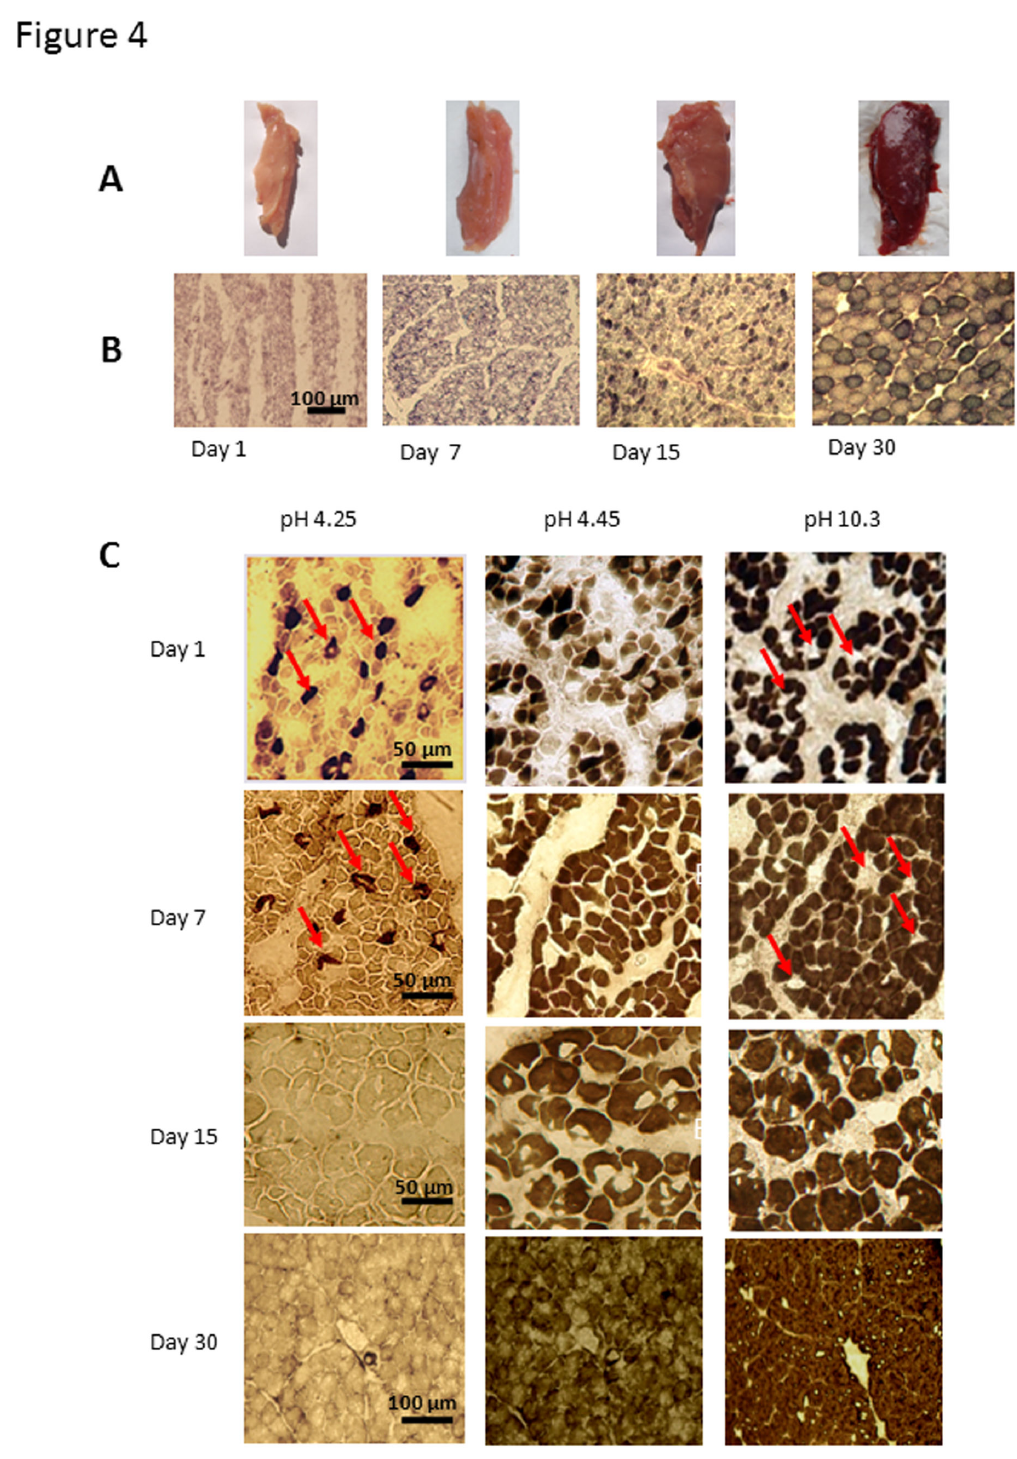
Figure 4. Morphological and histochemical properties of pectoralis muscle from 1 to 30 day -old Adélie chicks. Panels A - Pectoralis muscles showed a progressive red colour from hatching on D1 to D30. Panels B - The diameter and number of myofibers exhibiting strong NADH-TR (nicotine amide adenine dinucleotide tetrazolium reductase) activity increased with age. Panel C: Myosin ATPase reactions after preincubation at pH 4.25, 4.45 and 10.3, on pectoralis muscles from 1, 7, 15 and 30 -day- old Adélie chicks. Arrowheads show type 1 fibres. doi: 10.1371/journal.pone.0074154.g004 PLOS ONE |